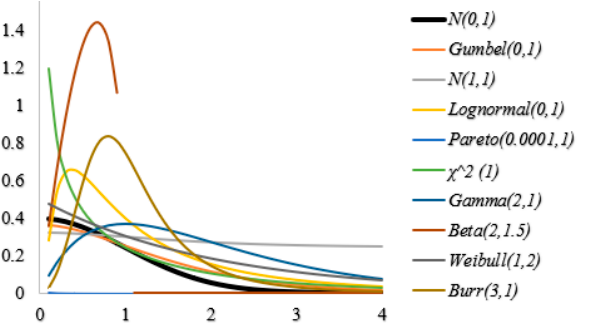
Figure 4. PDFs of asymmetric alternative distributions compared to the PDF of null 𝑁(0,1) distribution.